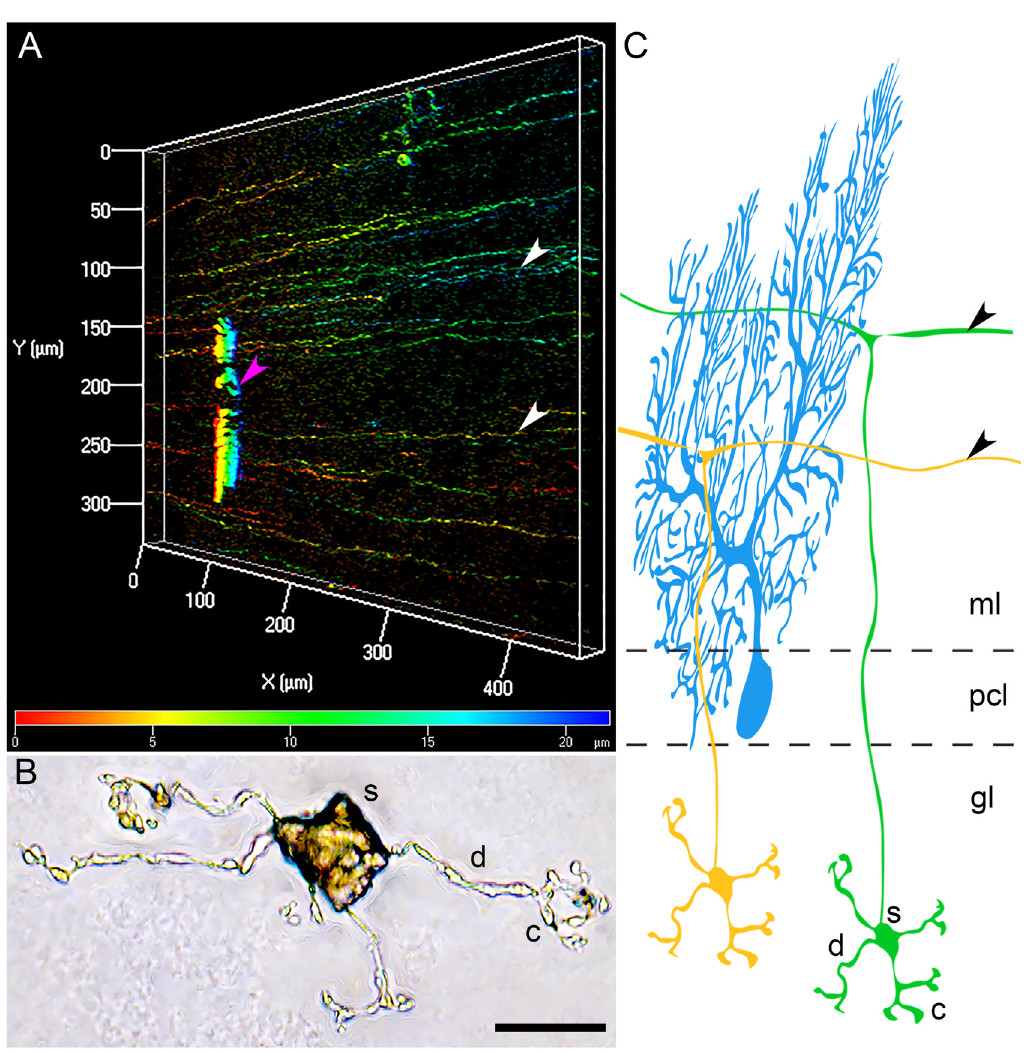
Figure 2. Morphology of the granule cell axons and dendritic claws. ( A ) Genetically labeled parallel fibers (white arrowheads) traversing the molecular layer along the mediolateral axis. A portion of a genetically labeled Purkinje cell dendritic arbor is also visible (magenta arrowhead). In this three-dimensional reconstruction, the pseudocoloring encodes the depth along the z-axis of the tissue section; the red pseudocolor indicates structures that are closest to the surface, and the blue pseudocolor indicates deeper structures. ( B ) A single granule cell labeled using the Golgi-Cox method. The dendrites and claws are revealed in exquisite detail. Scale bar = 10 μm. ( C ) A schematic depicting the structures shown in ( A ) and ( B ). Black arrowheads point to parallel fibers. c, claw; d, dendrite; gl, granular layer; ml, molecular layer; pcl, Purkinje cell layer; s,